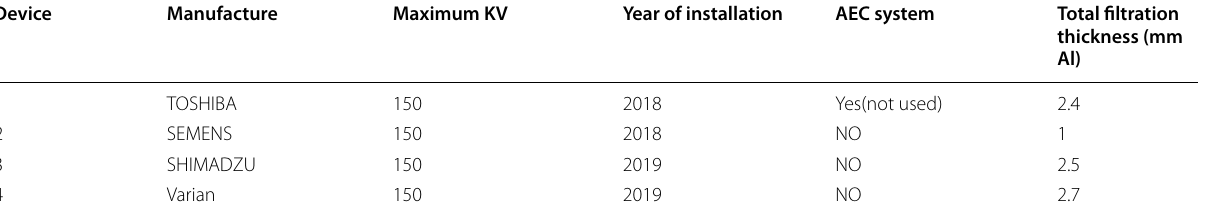
Table 1 The technical specifications of the devices Device